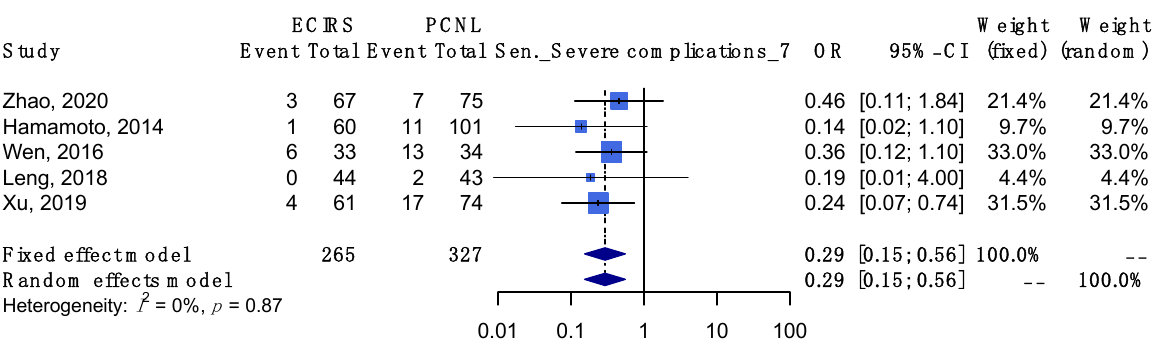
Figure A22. Sensitivity analysis of outcome regarding severe complications. ([17–19,22,23]).